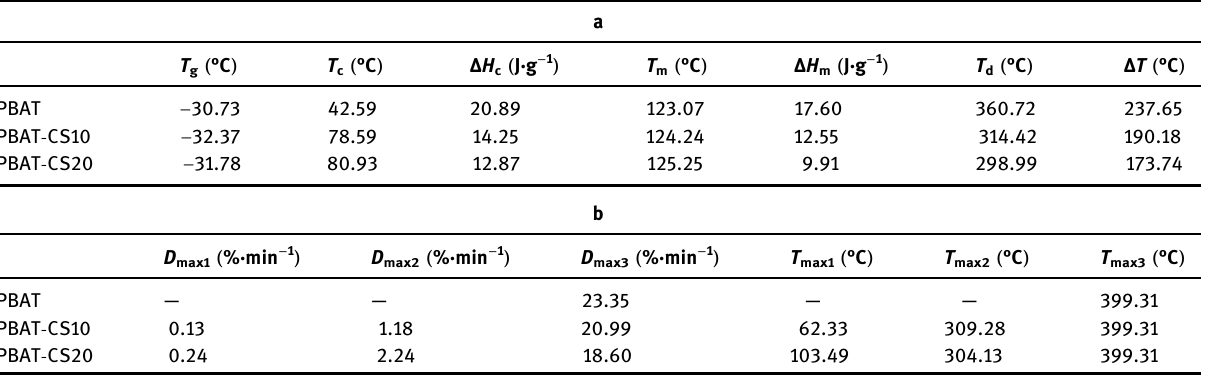
Table 2: Thermal properties of PBAT, PBAT - CS10, and PBAT -